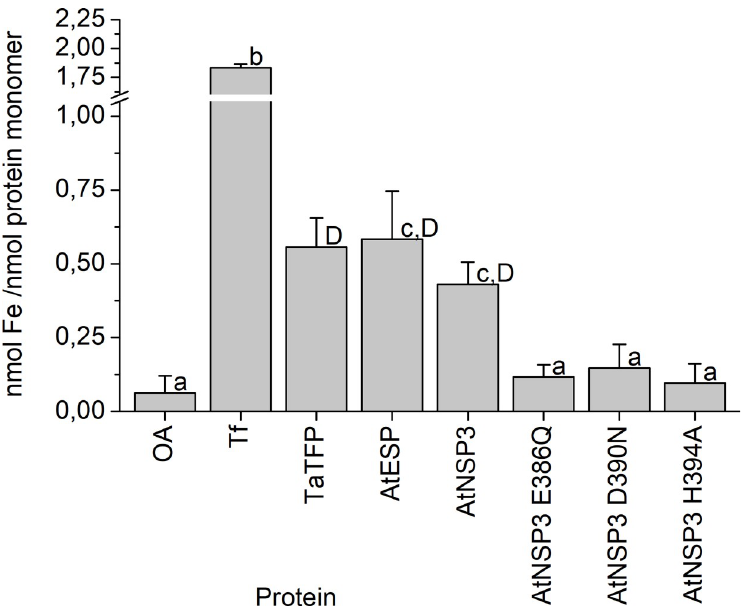
Fig 4. Ferene S quantification of iron in AtESP and AtNSP3 wildtype and mutants. Proteins (in 50 mM MES, pH 6.5, TaTFP in 6.25% (w/v) sucrose in 37.5 mM sodium acetate buffer, pH 5) were denatured and precipitated. Fe 2+ in the supernatant was quantified colorimetrically using Ferene S reagent and calibration with (NH 4 ) 2 Fe(SO 4 ) 2 . OA, ovalbumin; Tf, holo-transferrin. Shown are means ± SD (N = 3 independent expression experiments). Different letters above bars indicate a significant difference (p < 0.05; lower case letters: ANOVA with Tukey’s test (when errors were normally distributed); upper case letter: Kruskal-Wallis non-parametric test (non-normal errors)).